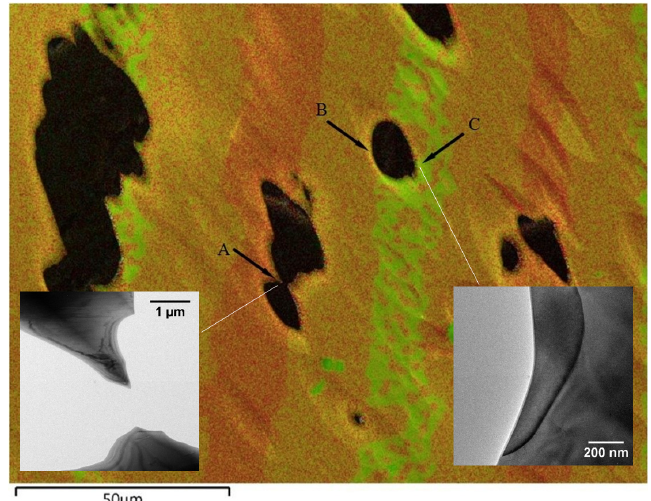
Figure 3. Integrated Zr-L α 1 (green) EDS map, Ni-K α 1 (red) EDS map, and SEM secondary electronic image (gray scale) obtained from thinned regions of a TEM sample used for diffraction identification of phases.